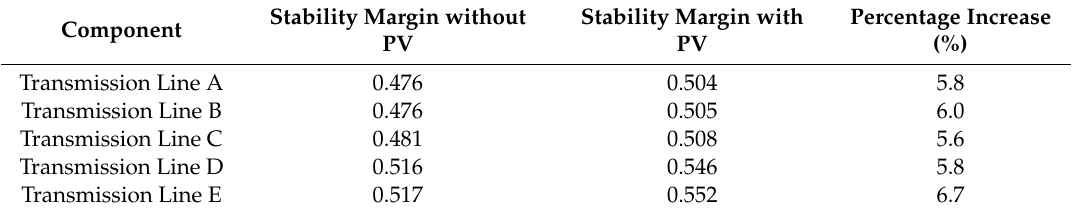
Table 2. Change in stability margins due to an increase in PV